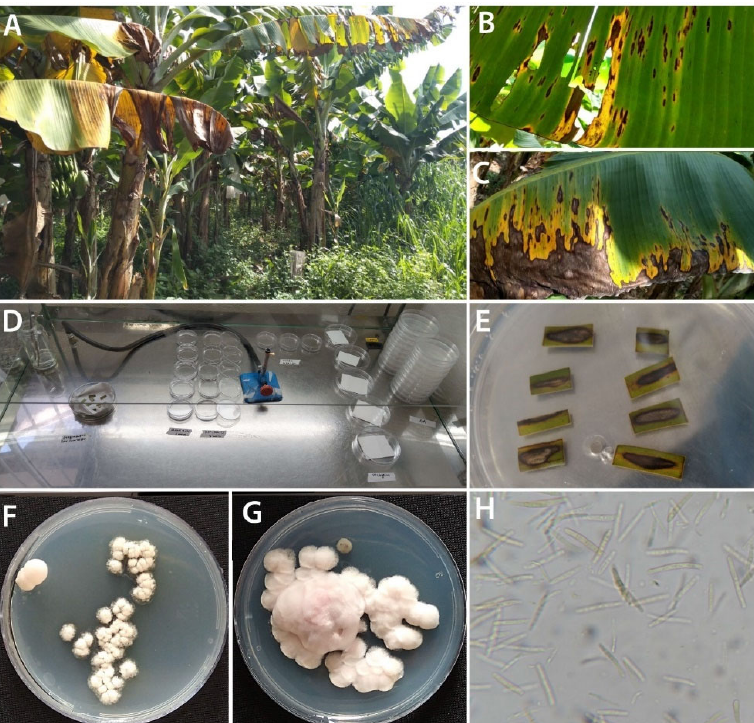
Figure 2. Banana plantation in Vale do Ribeira, SP ( A ). Infected banana leaves showing symptoms of yellow ( B ). and black ( C ). Sigatoka. Material used for indirect isolation of Sigatokas´ fungal pathogens ( D ). Fragments of banana leaves used for isolation ( E ). Mycosphaerella fijiensis colonies on PDA after 15 ( F ). and 60 ( G ). days incubation at 26 °C. Conidia suspension from a M. musicola